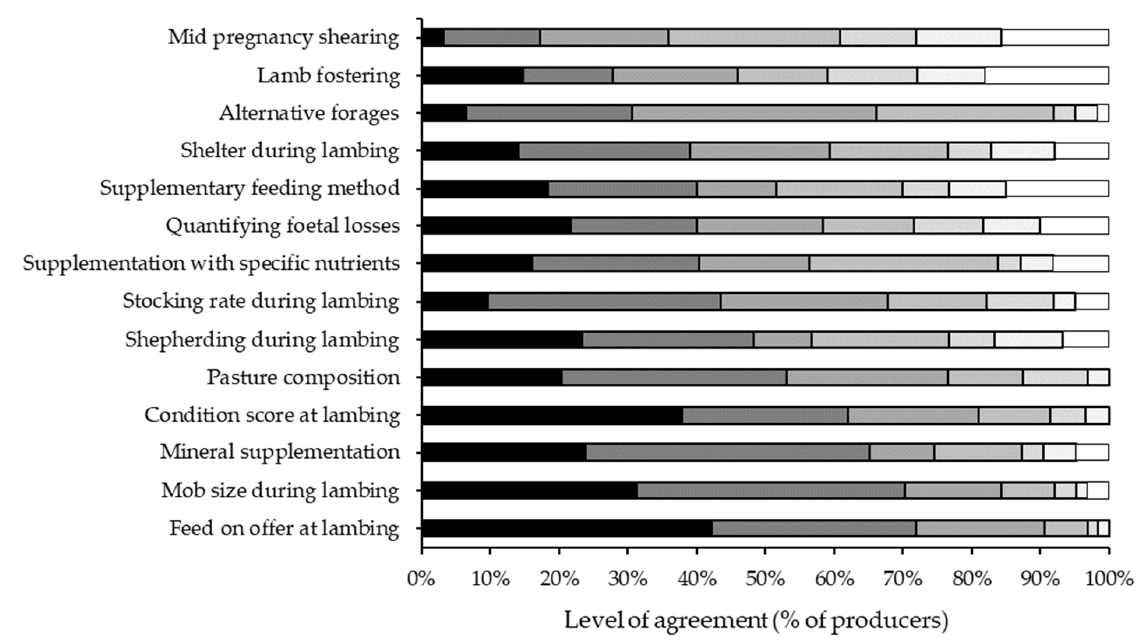
Figure 3. Percentage of respondents, on a seven-point scale ranging from strongly agree (on the left, black), agree, somewhat agree, neutral, somewhat disagree, disagree and strongly disagree (on the right, white), who believed further research was needed on different management options to reduce mortality of triplet-bearing ewes and/or improve the survival of their lambs. The respondents were sheep producers that attended workshops at sites across the sheep-producing regions of Australia or a webinar in 2019.